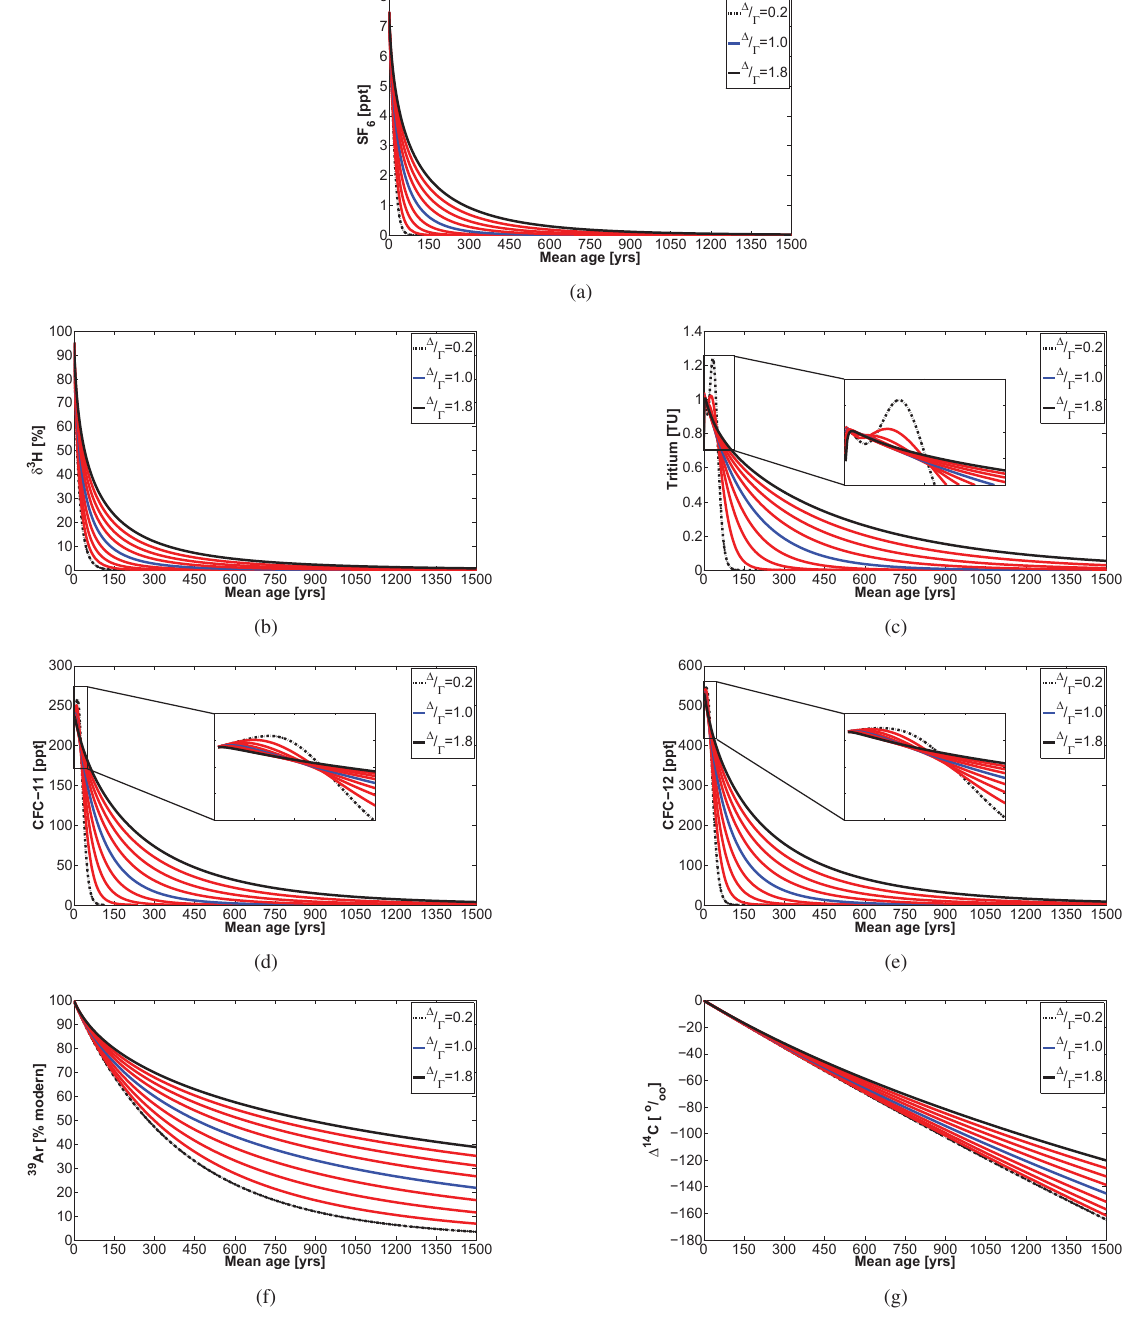
Fig. 2: Transient tracer concentration of ( a ) SF 6 , ( b ) δ 3 H , ( c ) Tritium, ( d ) CFC-11, ( e ) CFC-12, ( f ) 39 Ar, ( g ) Δ 14 C vs. mean Figure 2. Transient tracer concentration of (a) SF 6 , (b) δ 3 H, (c) tritium, (d) CFC-11, (e) CFC-12, (f) 39 Ar, and (g) (cid:49) 14 C vs. mean age for age for different Δ / Γ ratios. The standard ratio of 1 . 0 is shown as a blue line and the lower and upper limit as dashed and solid different (cid:49)/(cid:48) ratios. The unity ratio of 1.0 is shown as a blue line and the lower and upper limits as dashed and solid black lines, respectively. black line, respectively. The CFCs and tritium show a distribution anomaly which is caused by the decreasing atmospheric The CFCs and tritium show a distribution anomaly that is caused by the decreasing atmospheric concentration of the tracers. concentration of the tracers. shows the model output of the different transient tracers. The theoretical tracer concentrations were calculated for (cid:49)/(cid:48) ra- tios between 0.1 and 1.8 and a mean age spectrum